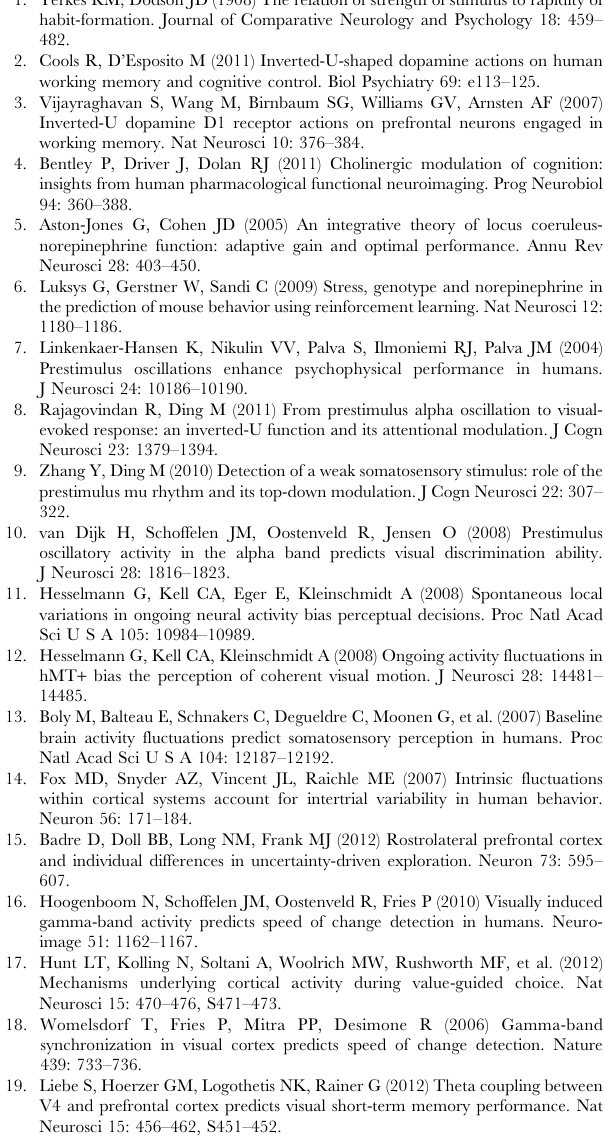
with hit rate (left column) or RT (right column), as well as electrodes showing both relationships with hit rate or RT. Data from Patients # 1, 2, 4 & 5 are included (see Fig. 6).